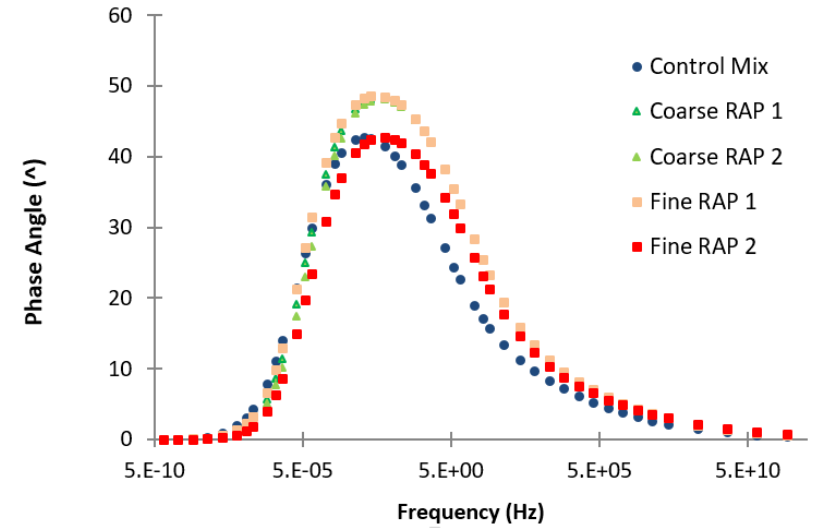
Figure 22. Master curve of the phase angle of complex modulus.